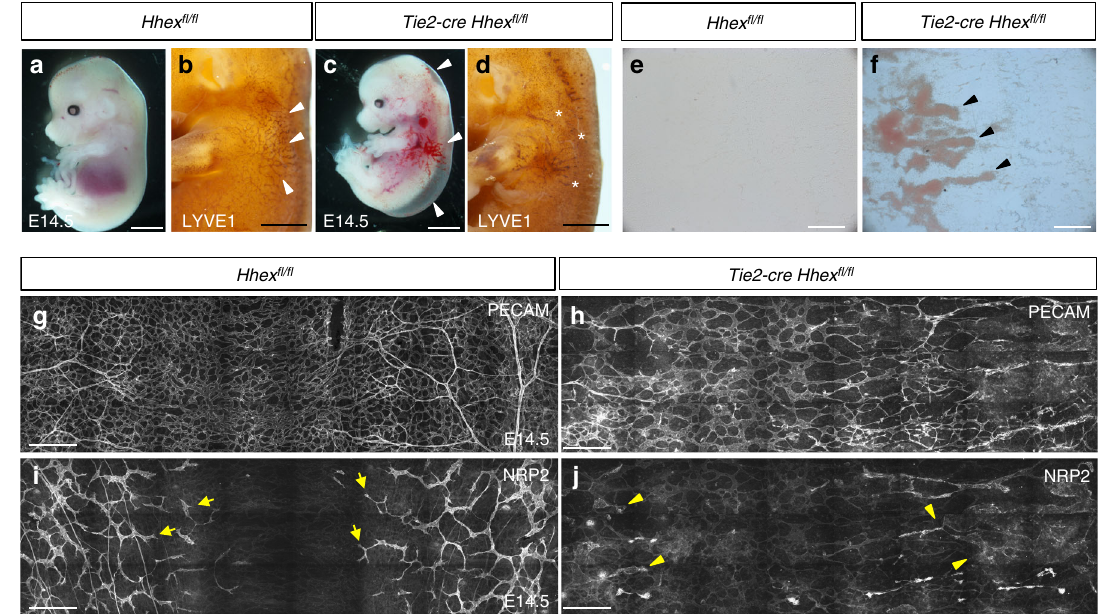
Fig. 7 Tie2-cre Hhex fl / fl mouse embryos exhibit strong vascular and lymphatic defects at E14.5. a – c Morphology of Hhex fl / fl and Tie2-cre Hhex fl / fl mouse embryos at E14.5. Hhex inactivation in Tie2 -expressing cells leads to lymphatic defects including edema and blood- fi lled lymphatics (arrowheads). b – d Whole-mount views of Hhex fl / fl and Tie2-cre Hhex fl / fl embryos at E14.5 after LYVE1 immunostaining. Hhex mutants exhibit defects in lymphatic patterning with a reduced lymphatic vasculature in the skin (arrowheads indicate LYVE1 + lymphatic vessels, asterisks indicate lack of these vessels in the same area in Tie2-cre Hhex fl / fl ). e , f Bright fi eld pictures of Hhex fl / fl and Tie2-cre Hhex fl / fl skin at E14.5. Hhex mutants exhibit blood- fi lled lymphatics (arrowheads). g , h Whole-mount views of Hhex fl / fl and Tie2-cre Hhex fl / fl skin at E14.5 after PECAM immunostaining. Hhex mutants exhibit strong vascular defects at E14.5. i , j Whole-mount views of Hhex fl / fl and Tie2-cre Hhex fl / fl skin at E14.5 after NRP2 immunostaining. Hhex mutants exhibit strong lymphatic defects at E14.5 (arrows point to lymphatic vessels; arrowheads point to blood- fi lled lymphatic vessels with decreased intensity of NRP2 immunostaining). Scale bars: 2 mm ( a , c ), 1 mm ( b , d ), 200 μ m ( e , f ), and 250 μ m ( g – j